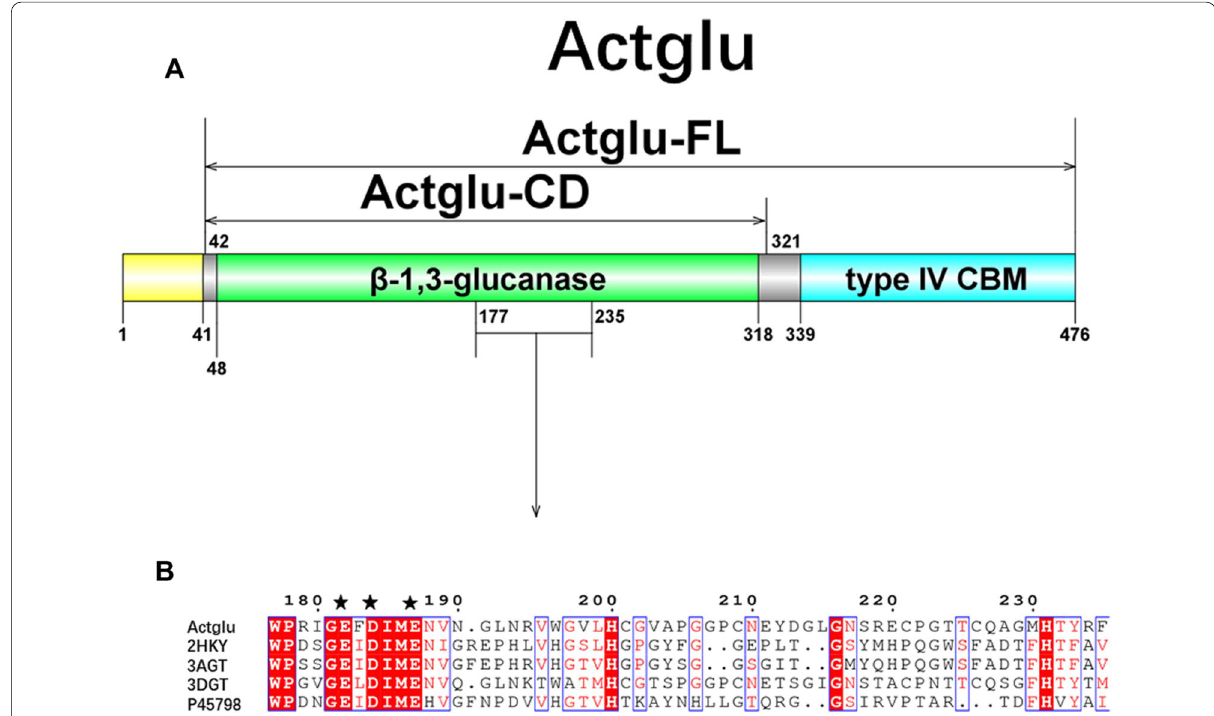
Fig. 2 Schematic diagram of Actglu A and multiple sequence alignment of the active site ( B ). The yellow region is the signal peptide. The green region is the β-1,3-glucanase catalytic domain.The blue region is the type IV carbohydrate-binding domain (CBM). Multiple sequence alignment shows that Actglu has the conserved motif EXDXXE in the active site. The sequence marked with black five-pointed star is the conserved motif in the active